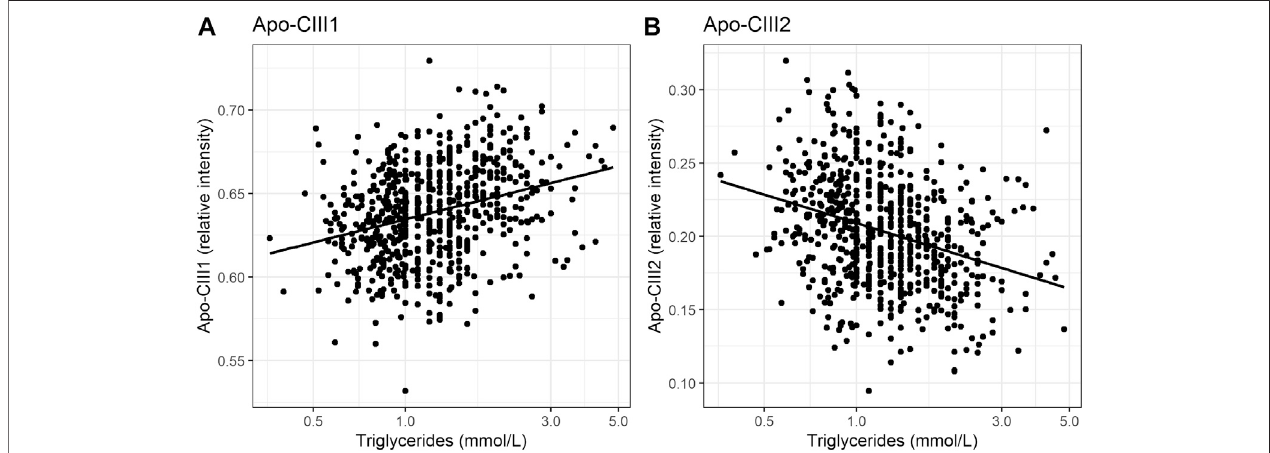
FIGURE 3 | Relationship of apo-CIII1 [panel (A) ] and apo-CIII2 [panel (B) ] with triglycerides.